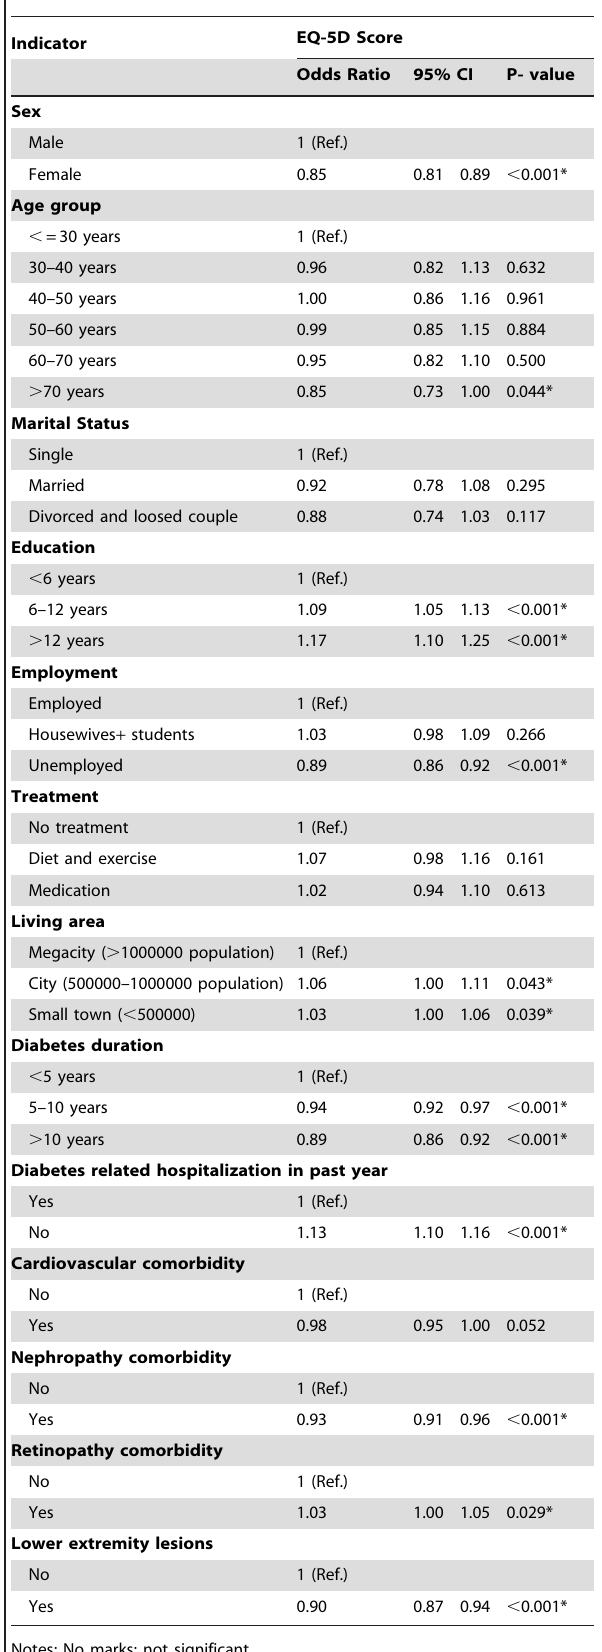
Table 5. Results of Tobit regression model.